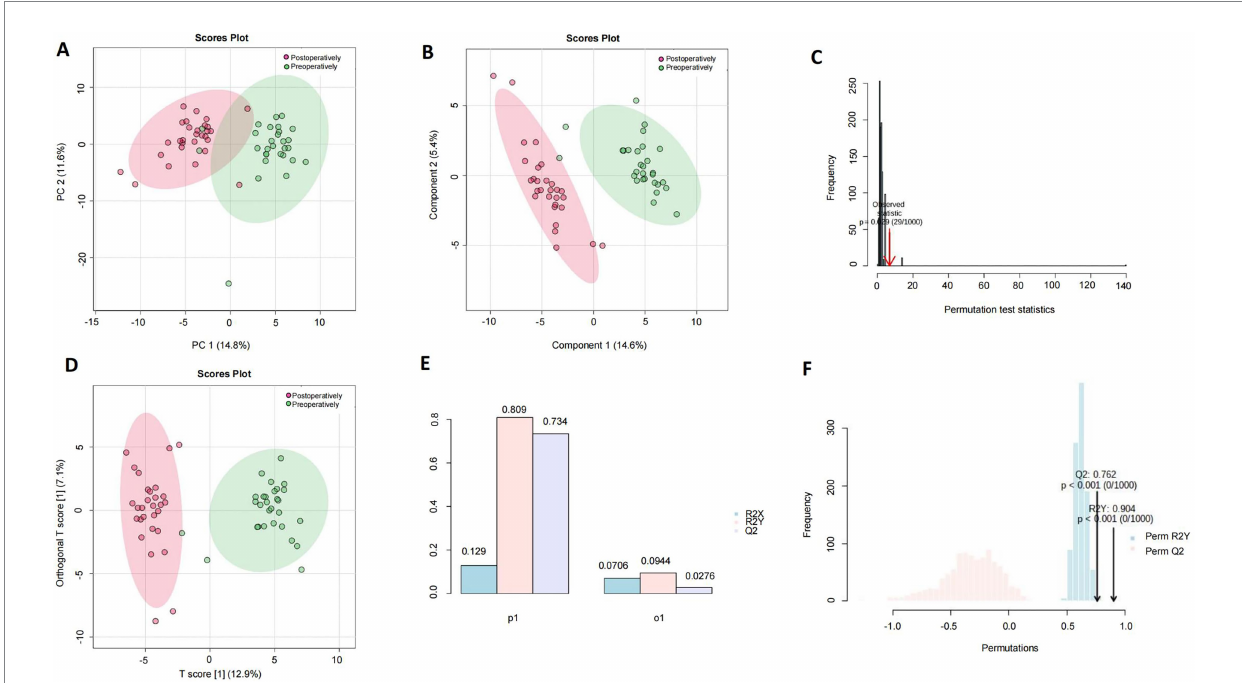
FIGURE 1 Analysis of differential metabolites in the serum of patients undergoing general anesthesia before and after surgery. The human preoperative serum is the control group (green dot), while the postoperative serum is the anesthesia group (red dot). (A) A plot of PCA scores for PC1 and PC2 extracted from human serum ( n = 29). (B) Component differences between control and anesthesia groups in the OPLS-DA model of human serum metabolites. (C) PLS-DA model 1,000 permutation test results, the value of p was 0.029. (D) Control (green dots), and anesthesia (red dots) groups were completely separated on OPLS-DA two-dimensional score plot. (E) Human serum control and anesthesia groups OPLS-DA two-dimensional score plot model parameters. (F) OPLS-DA model 1,000 permutation test results, Raw p -value